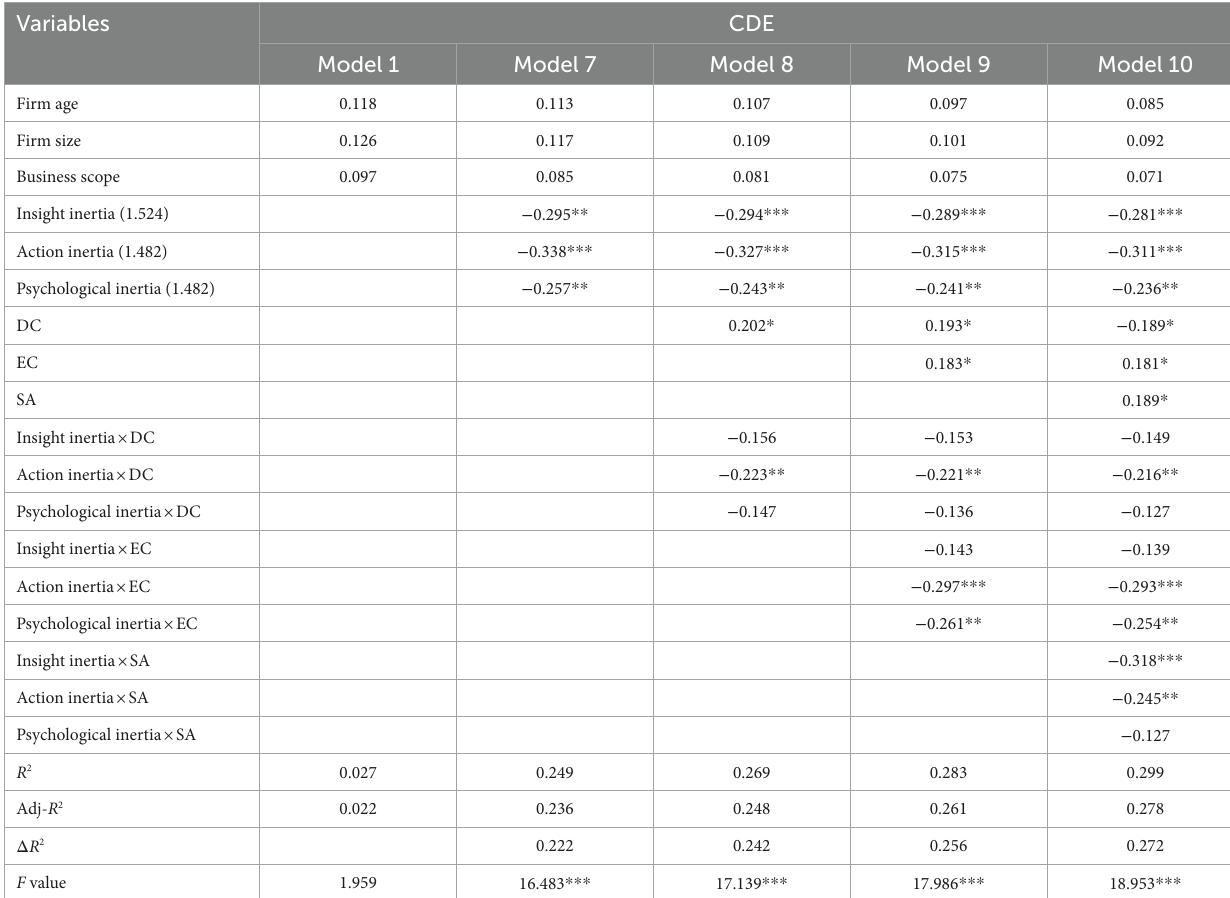
TABLE 5 The results of regression analysis on interaction effect of moderators and OI.